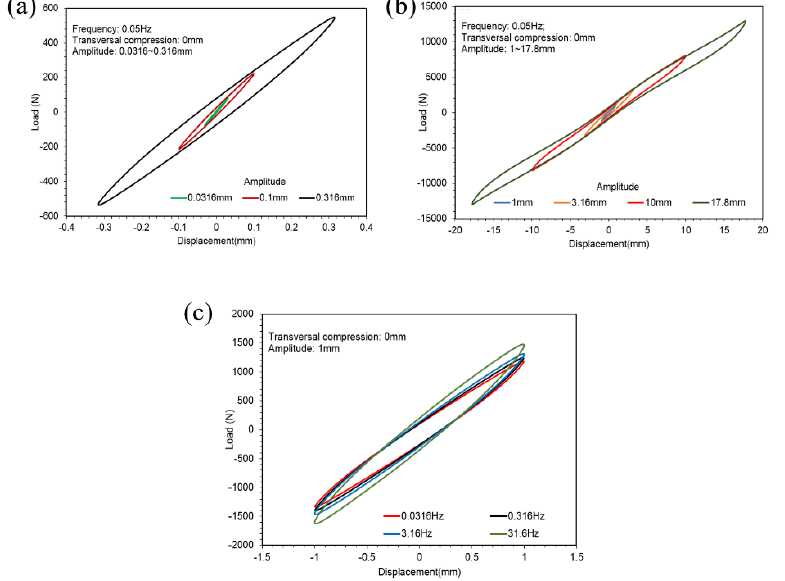
Figure 5. Hysteresis loops of the ST rubber spring. ( a , b ) Hysteresis loops of different amplitudes of the ST rubber spring in 0.05 Hz without transversal compression. ( c ) Hysteresis loops under different frequencies in amplitude 1 mm without transversal compression.